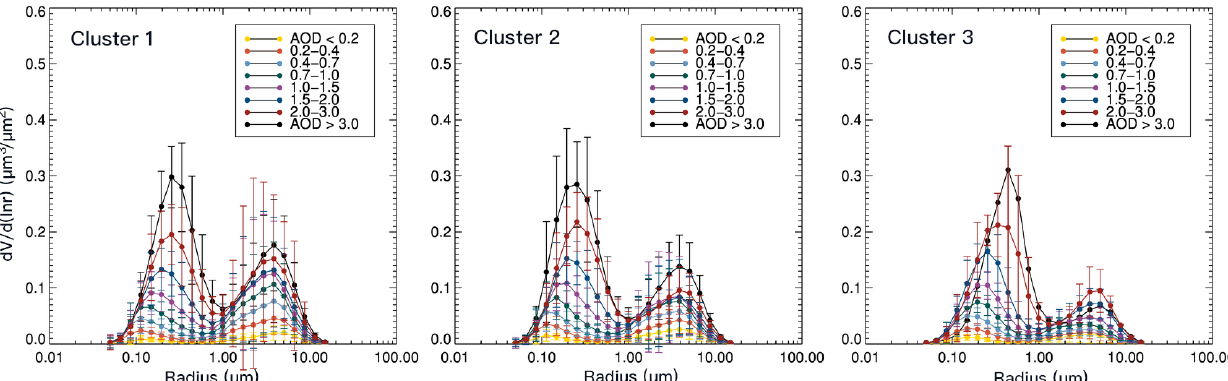
Figure 4. Size distribution as a function of AERONET AOD at 0.675µm, generated from the AERONET inversion products at three clusters illustrated in Fig. 3 using all available data records. Other than the last AOD bin, which is AOD > 3, the number of retrievals within each AOD bin is between hundreds and thousands. There are 263, 15, and 1 data points in the highest-AOD bin for cluster 1, 2, and 3, respectively. The error bars represent the standard deviation within each size bin.